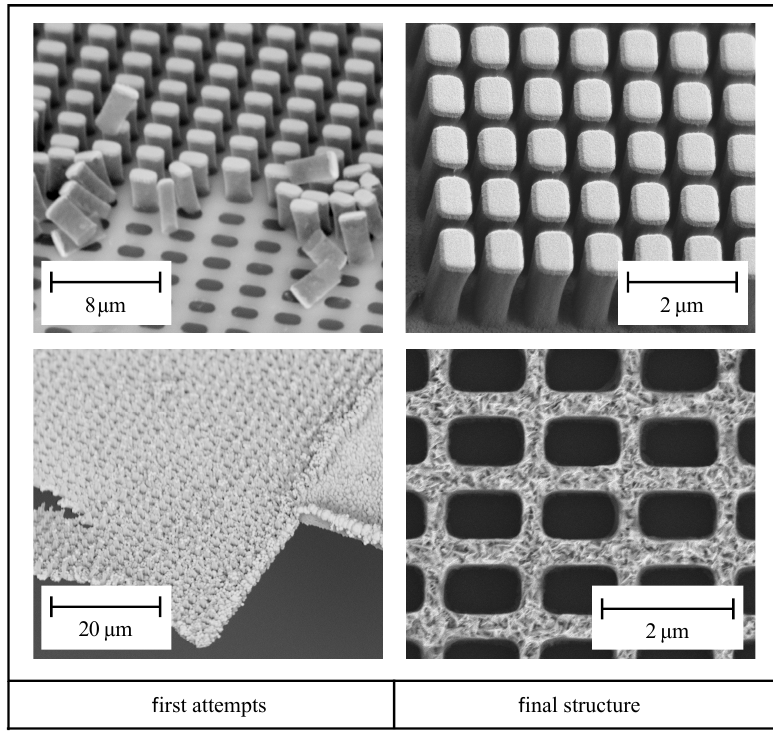
Figure 4. SEM images to compare the challenges from the first attempts ( left ) to the final fabrication ( right ). The top images show the freestanding pillars resulting from the subtractive process and the bottom images the final HWA